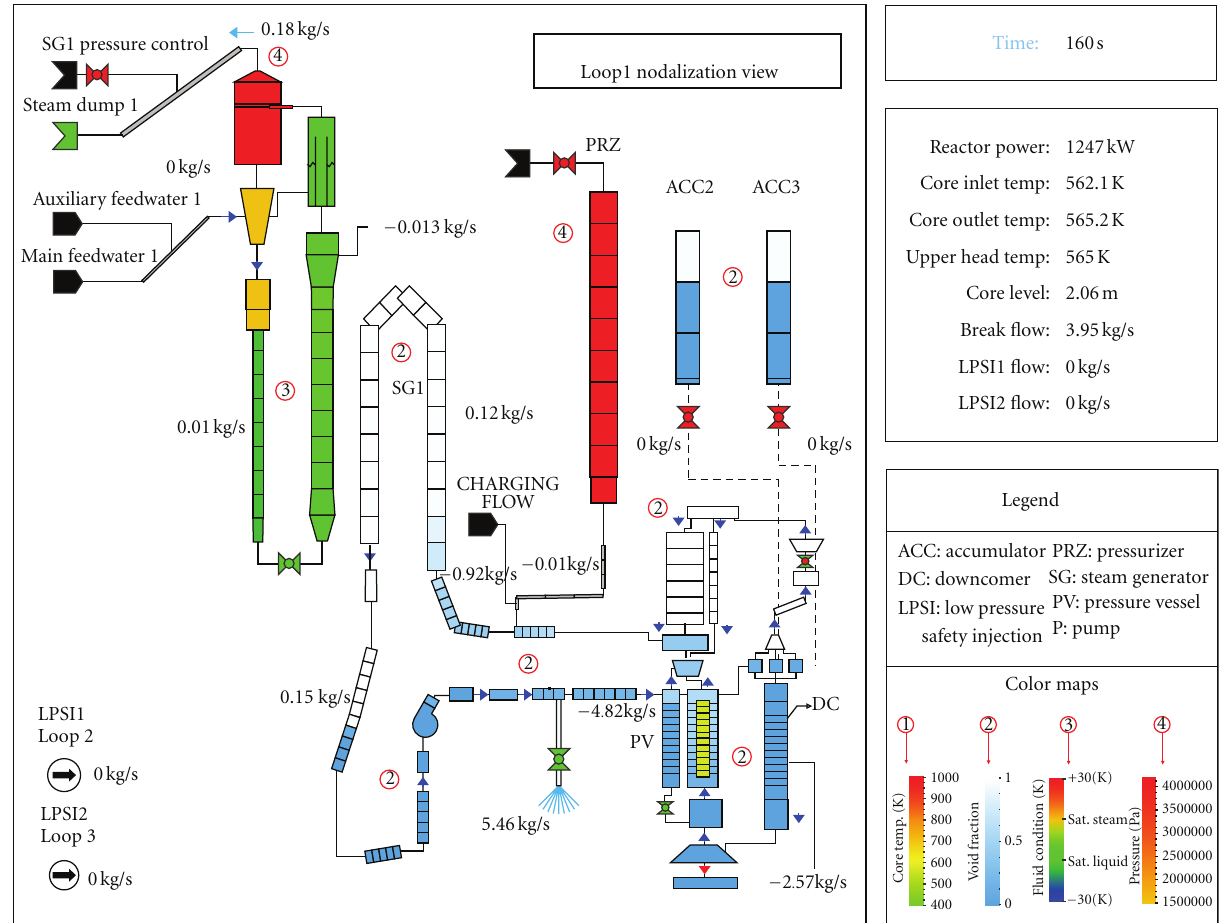
Figure 20: Animation mask for TRACE at time t = 160 s (before loop seal